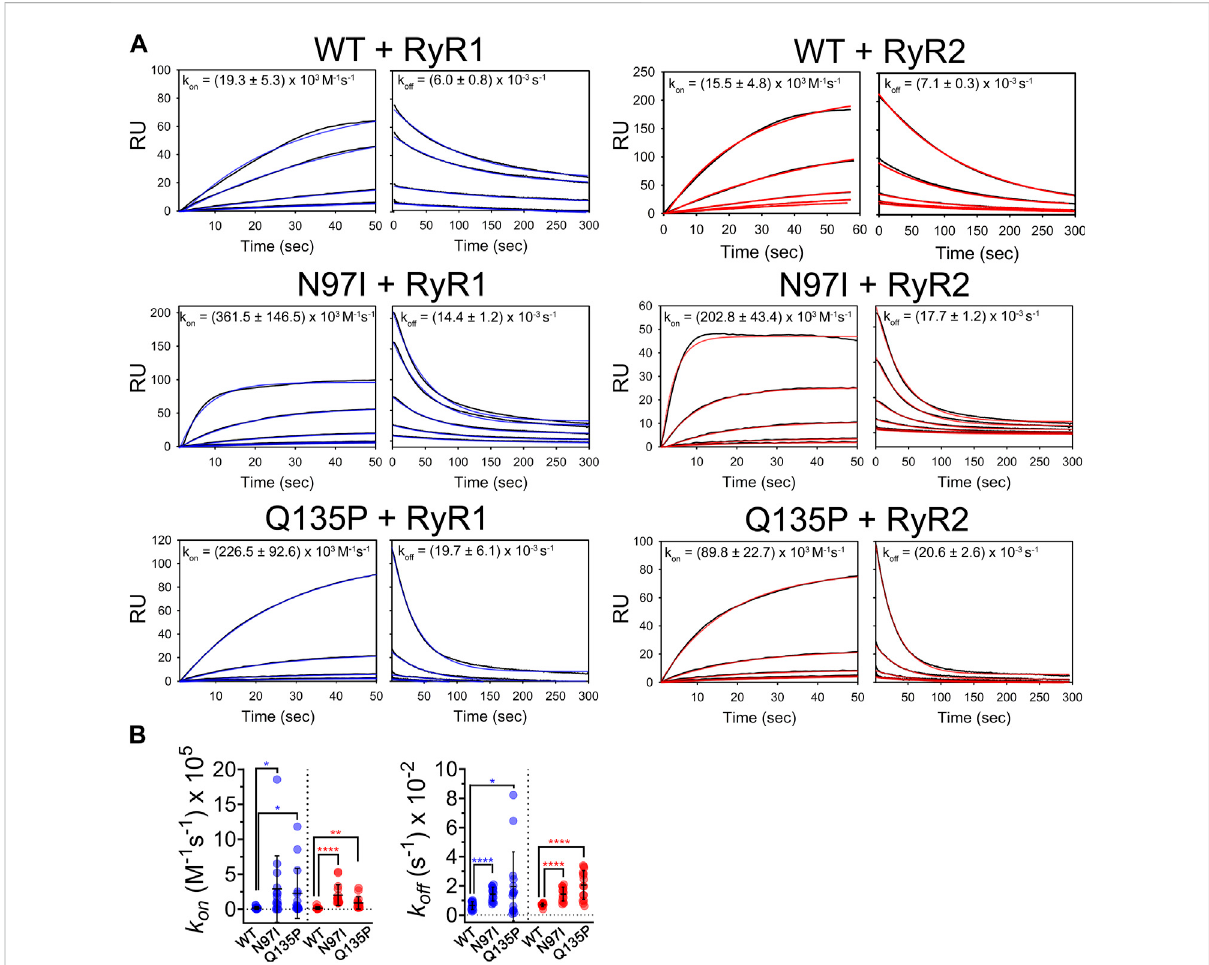
FIGURE 6 KineticsofCaM-RyR1/2peptideinteractioninvestigatedbysurfaceplasmonresonance. (A) Sensorgramscollectedby fl owingdifferentamountsof RyR1andRyR2(125 nM — 2 µM)onimmobilizedHis-CaMvariantsusing20 mMTrispH7.5,150 mMKCl,0.005%Tween20,5 mMCa 2+ ,100 µMDTTasa running buffer. Association and dissociation phases were followed for 60 s and 300 s, respectively. Experimental curves (black solid lines) are shown together with theoretical curves (red or blue solid lines) according to a 1:1 Langmuir binding model; fi tting for association and dissociation phases led to the rate constants ( k on and k off ) reported in each panel (mean ± s.e.m. of 8-20 independent binding curves). (B) Scatter plot of replicates and statistical analysis comparing rate constants for WT and each pathogenic CaM variant. Stars represent p -values: * p ≤ 0.05, ** p ≤ 0.01, **** p ≤